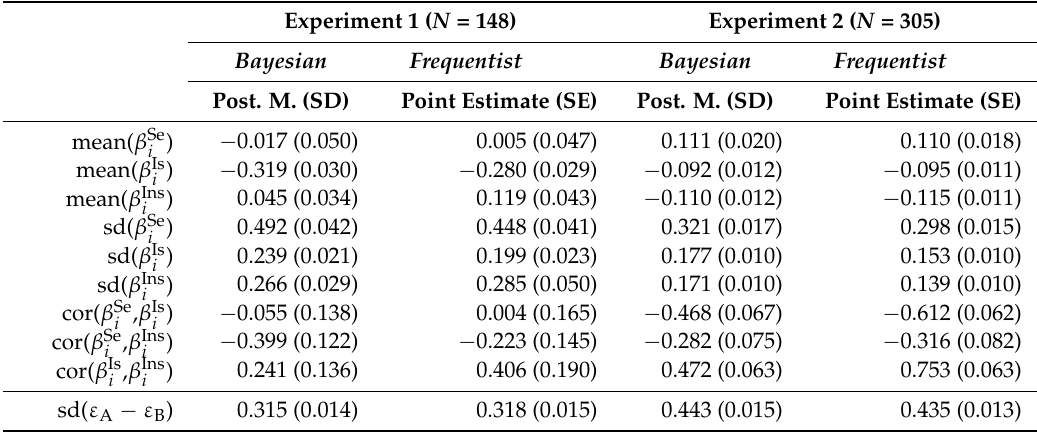
Table A2. Frequentist and Bayesian Estimates of Model